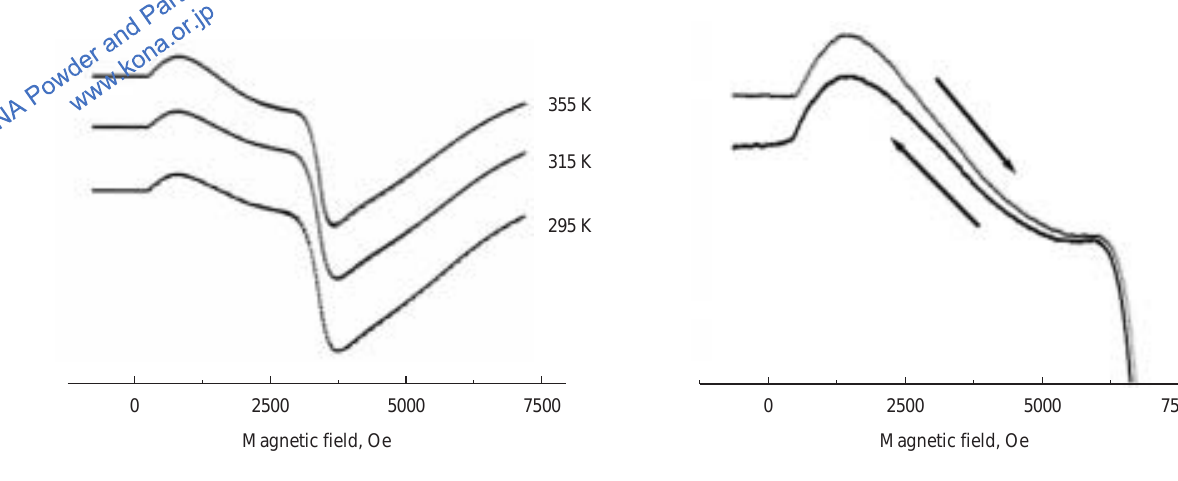
Fig. 8 EPR spectra measured at different temperatures for Fe- containing samples.